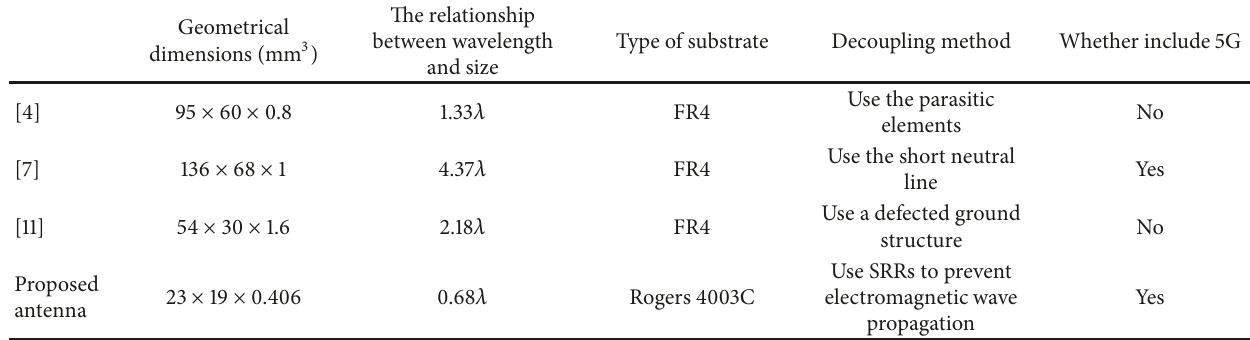
Table 2: Comparison of proposed antenna and previous equivalent